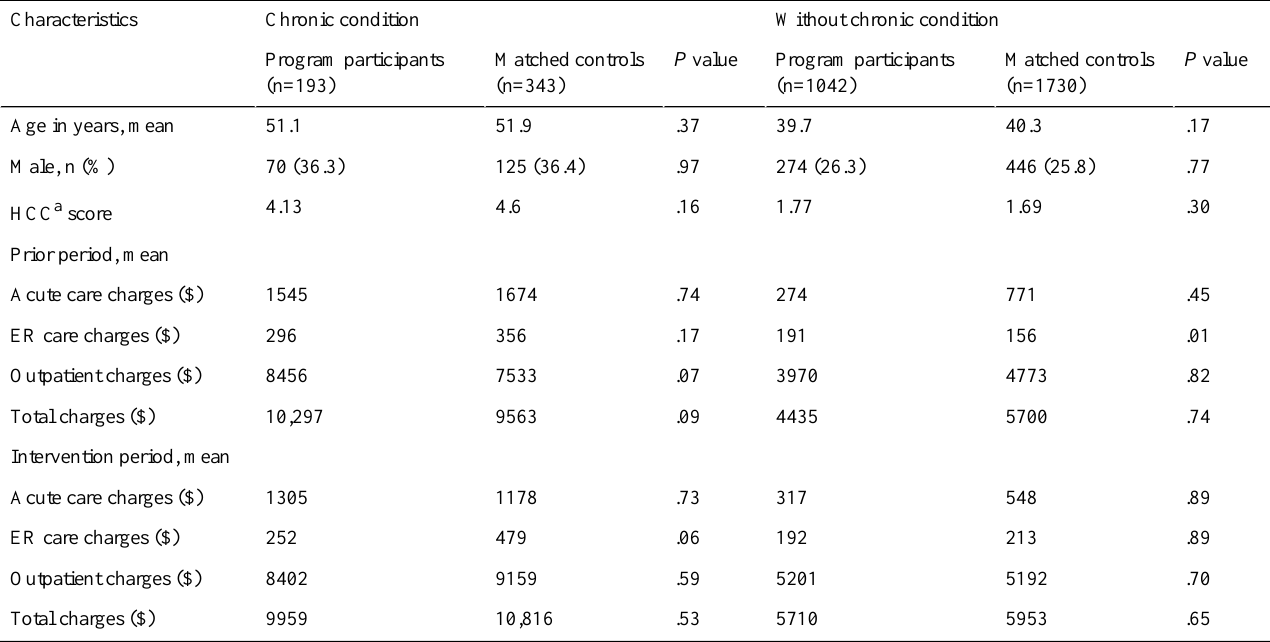
Table 3. Comparison of the characteristics and pre- and postintervention charges for program participants and matched controls in the with and without chronic condition cohorts (actual mean values are provided, but P values for charge data are based on results using log-transformed data).